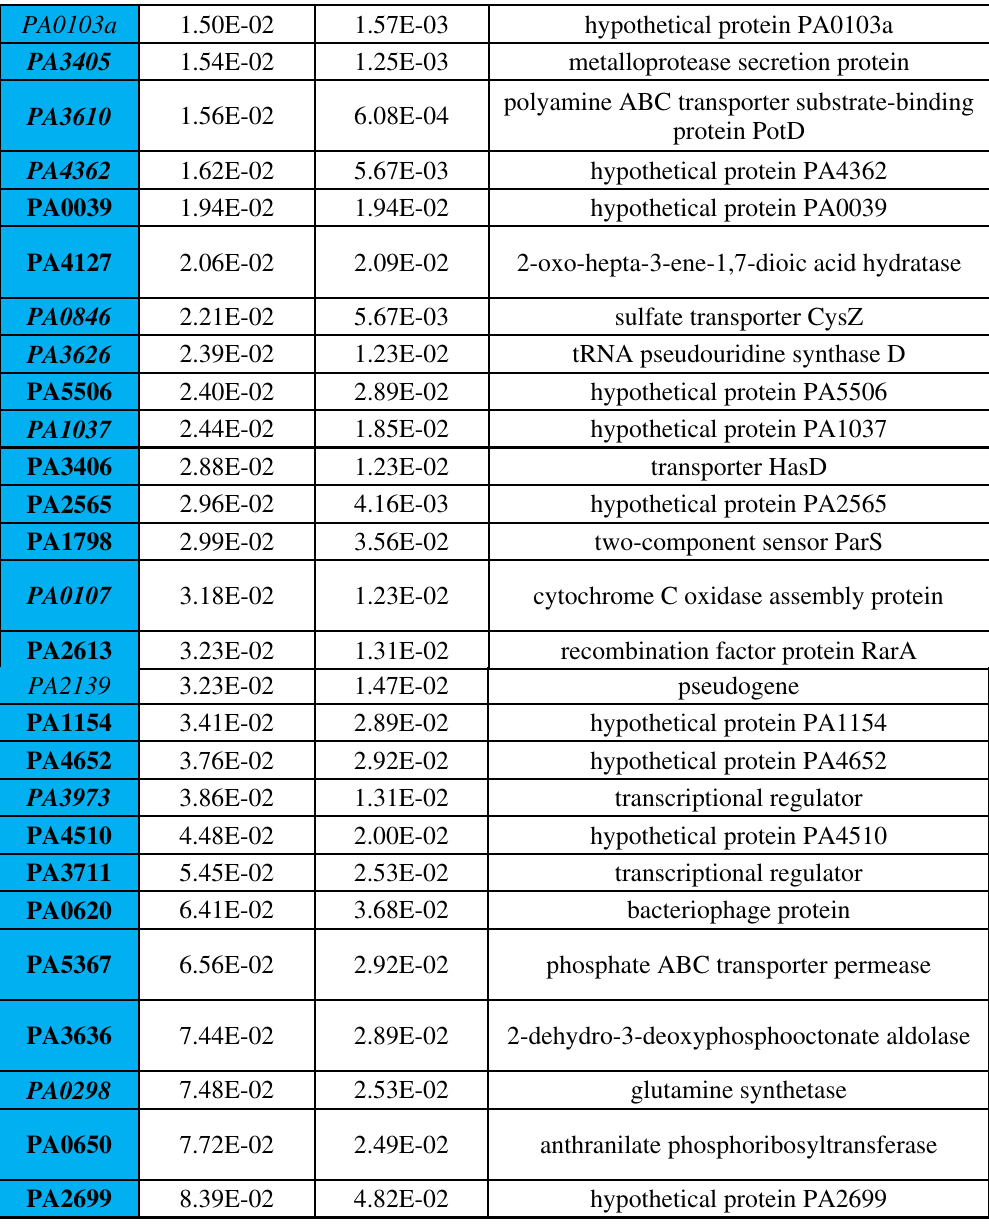
Table 2. Statistically significant DEGs of VBNC-like colonies. VBNC-like colony transcripts were compared to the control lawn to identify genes which were significantly up or down regulated. Red indicates genes which were significantly upregulated and blue indicates genes which were significantly downregulated. Genes in bold were screened using transposon mutants. Genes in italics are shared by both phoenix colonies and VBNC-like